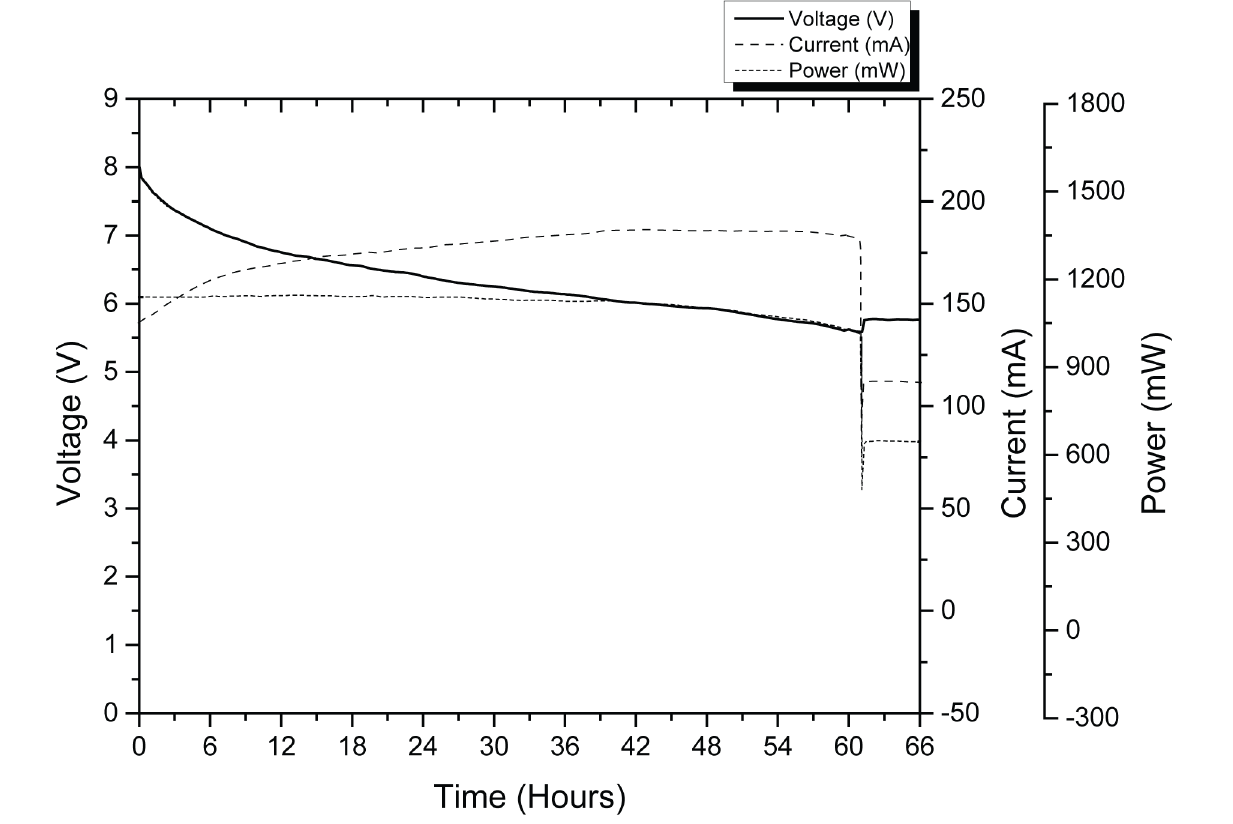
Fig 7. Battery discharge behavior registered while recording (at 48 kHz) and post-processing